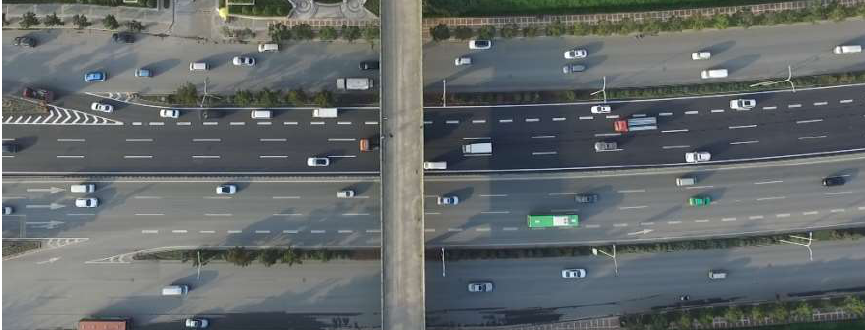
Figure 1. Range of aerial photography of